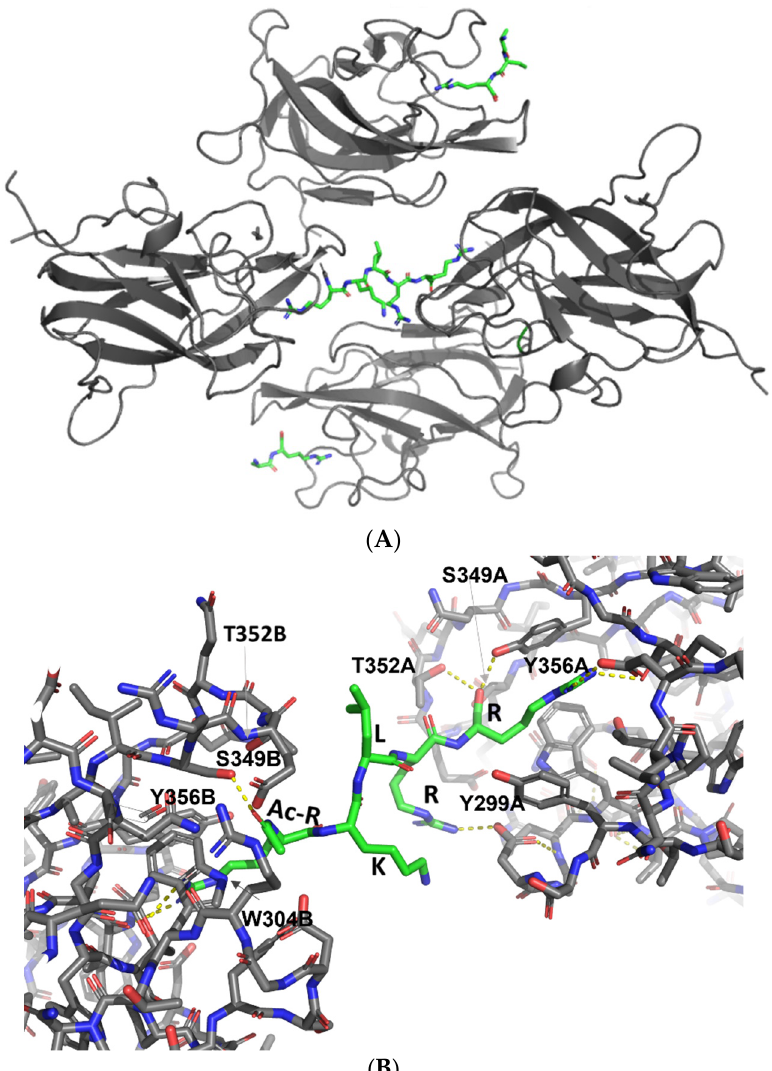
Figure 2. ( A ). The content of the asymmetric unit within the structure of NRP2-b1 domain in a complex with B167 peptide. Four molecules are shown as grey ribbons while the peptidic ligands are represented as sticks coloured by atoms. The two peptides with only two/three modeled amino acids are at the top and the bottom, whereas the peptide with five modeled amino acids (represented in Figure 1, right) is in the center. ( B ). Close-up view of interactions between B167 peptide and the two neuropilin chains within the crystal structure. The residues within the peptide sequence RKLRR are labeled and the N-terminal acetylated arginine of the peptide is indicated by Ac-R. The structures are shown as sticks with the neuropilin carbon atoms within chains A and B coloured grey while the carbon atoms of B167 peptide are coloured green. All nitrogen and oxygen atoms in the figure are coloured blue and red, respectively. Hydrogen bonds formed by the peptide are denoted by dashed yellow lines.